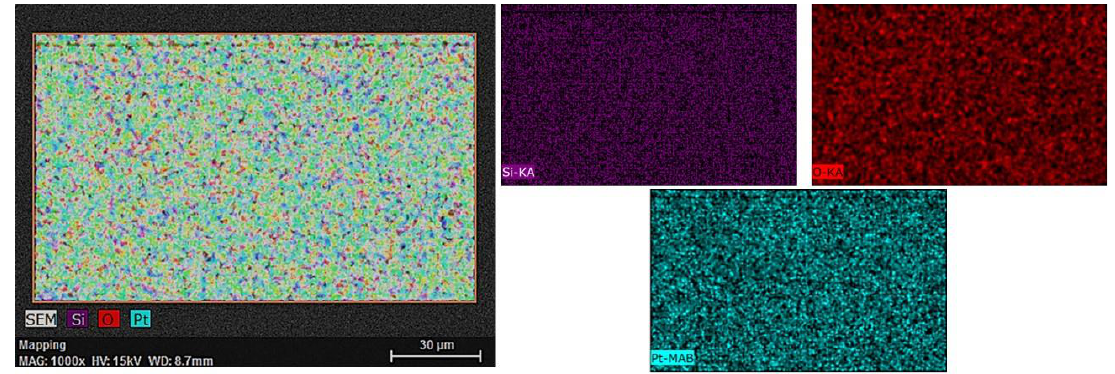
Figure 2. Graphical elemental mapping for Pt thin film deposited on Si substrate at 1000× magnification and 15 kV acceleration voltage.